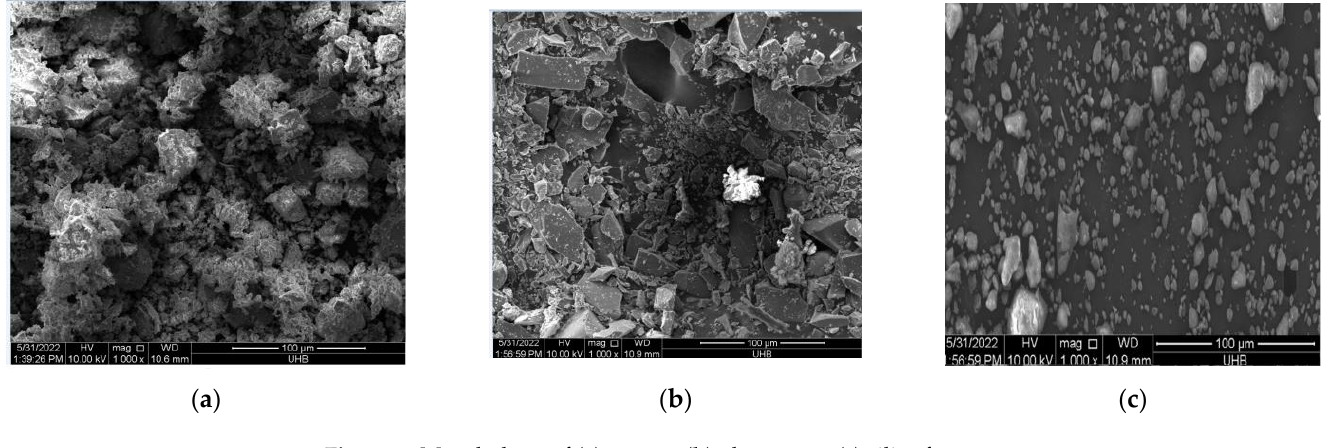
Figure 3. Morphology of ( a ) cement ( b ) glass waste ( c ) silica fume.